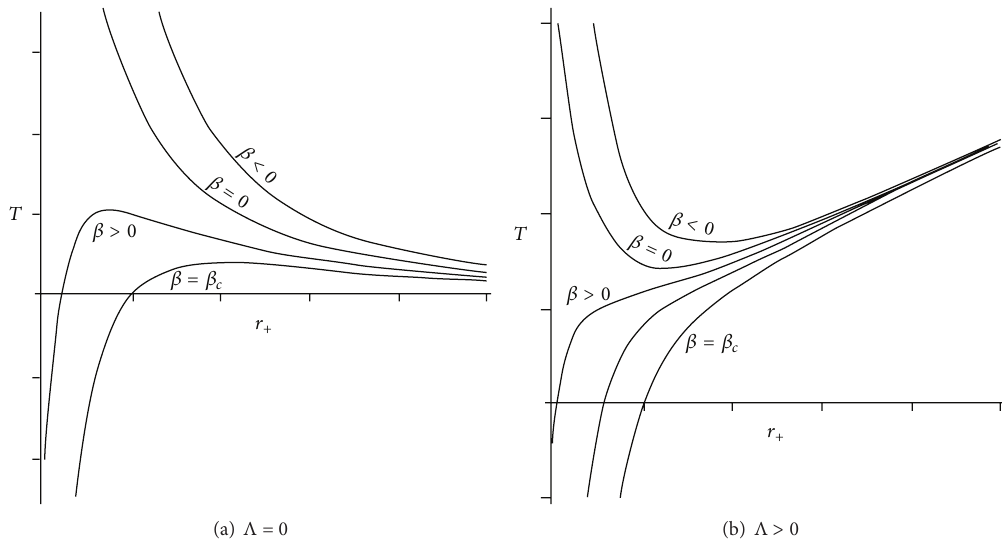
Figure 2: Temperature of the black hole as function of the radius of the event horizon 𝑟 + for different values of Λ and 𝛽 . In (a), we set Λ = 0 . For 𝛽 = 0 , we obtain Schwarzschild’s temperature and a similar behaviour for 𝛽 < 0 . Values of 𝛽 > 0 give a temperature that goes to zero for an extremal black hole remnant configuration. In (b), we set Λ > 0 . The value of 𝛽 = 0 gives Schwarzschild-AdS temperature and similar behaviour for 𝛽 < 0 . Values of 𝛽 > 0 give again a function that goes to the zero temperature extremal black hole. In both cases, the value 𝛽 = 𝛽 𝑐